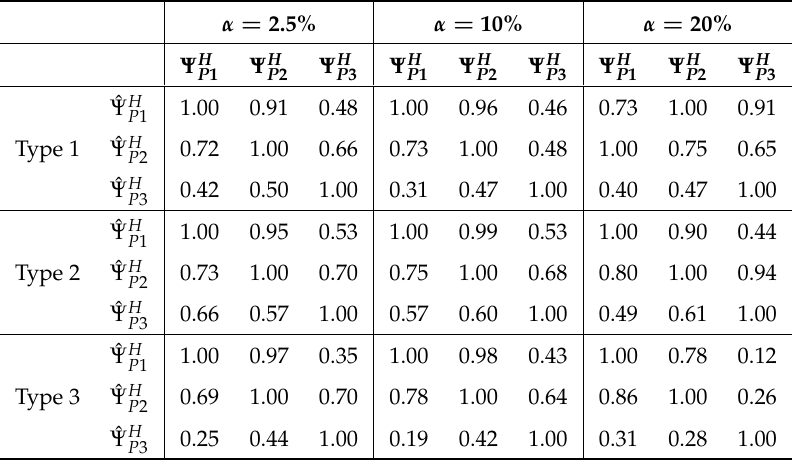
Table 3. Cross-correlation tables of the estimated signals ( ˆ Ψ H ) against measured signals ( Ψ H ) from each pavement section (P1 to P3) for the three types of trucks under α = 2.5%, 10%, and 20% levels of noise. α = 2.5% α = 10% Ψ H P